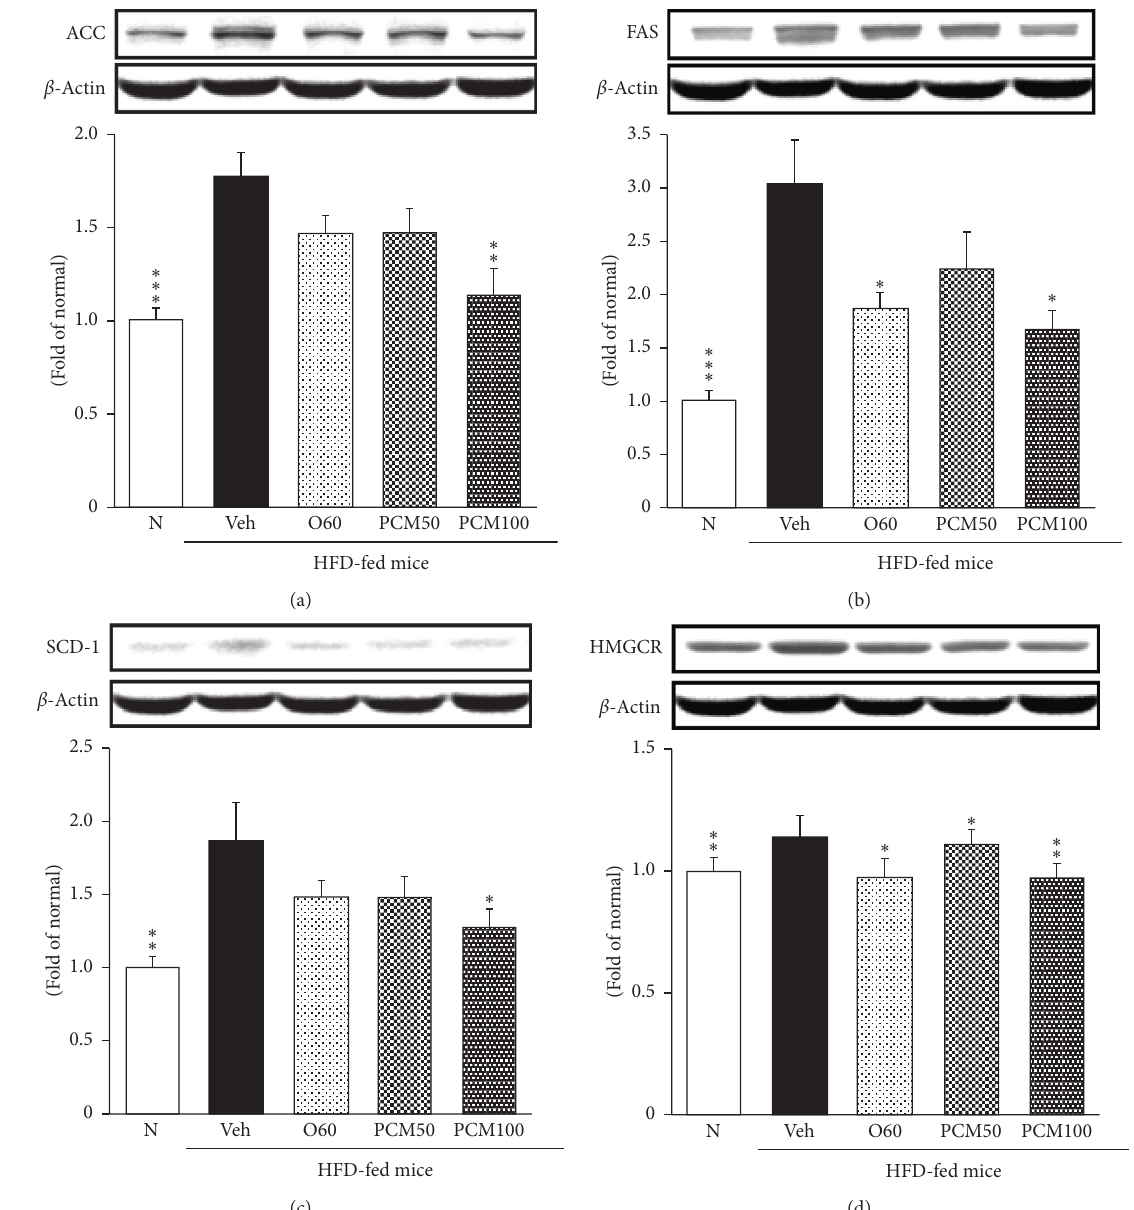
Figure 6: ACC (a), FAS (b), SCD-1 (c), and HMGCR (d) protein expressions in the liver. N, normal mice; Veh, HFD control mice; O60, orlistat 60mg/kg-treated and obese mice; PCM50, PCM 50mg/kg-treated and obese mice; PCM100, PCM 100mg/kg-treated and obese mice. Data are the mean ± SEM, n � 7. Significance: ∗ p < 0.05, ∗∗ p < 0.01, and ∗∗∗ p < 0.001 versus HFD control mice. ACC, acetyl-CoA carboxylase; FAS, fatty acid synthase; SCD-1, stearoyl-CoA desaturase-1; HMGCR, 3-hydroxy-3-methylglutaryl coenzyme A